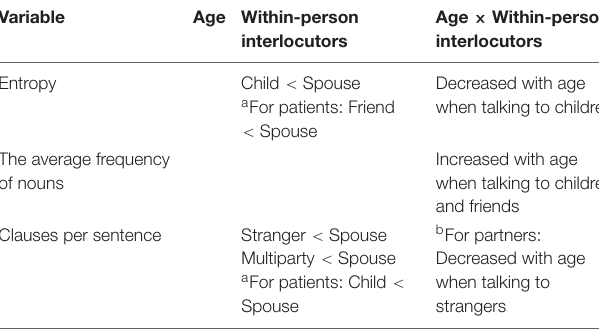
TABLE 4 | Summary of significant fixed